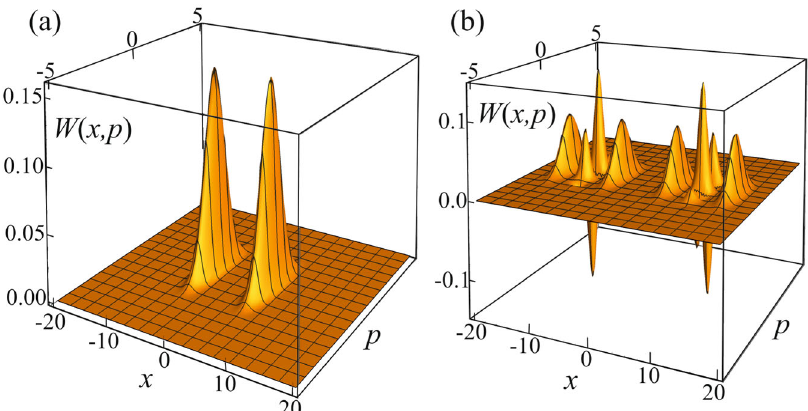
ffiffiffi p 2 and E J / ℏ ω = 1.4 is plotted at time ( a ) t = t s and ( b ) t = 3 t s ,